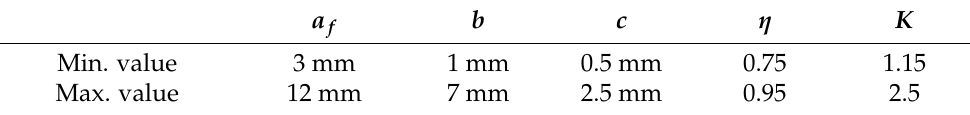
Table 4. Minimum and maximum values for the known parameters θ , as determined by the experts.